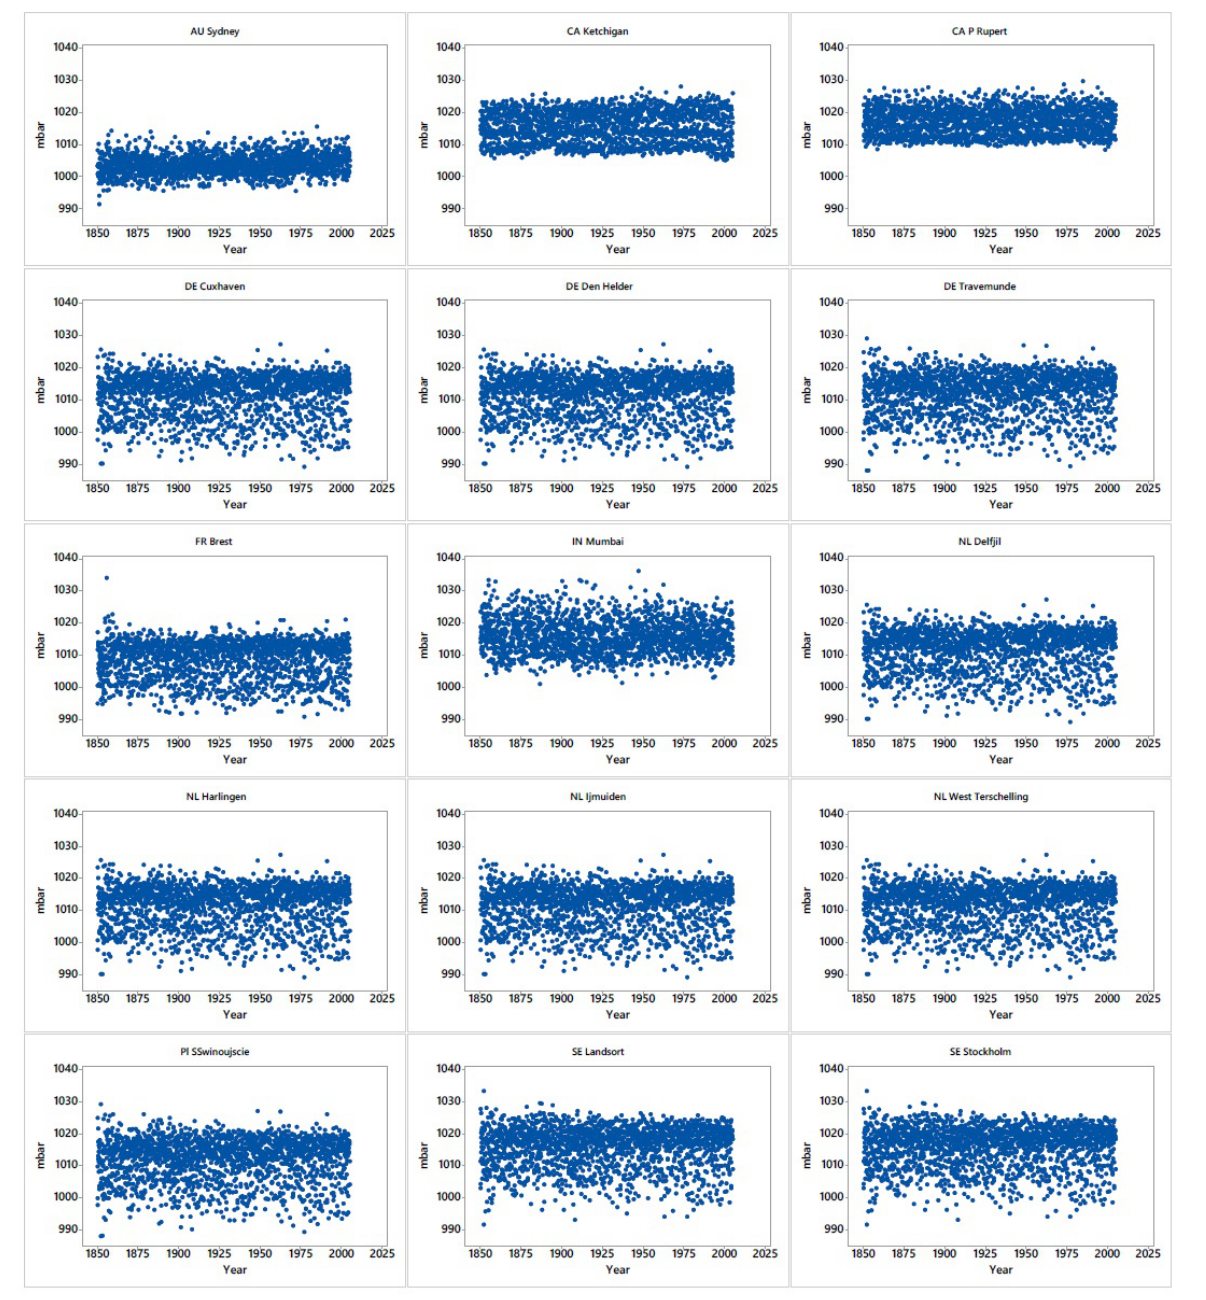
Figure 2: Regional atmospheric pressure time series at 27 globally distributed tide gauge stations with long records. Some of the records are identical because of the proximity of the tide gauge stations to each other.